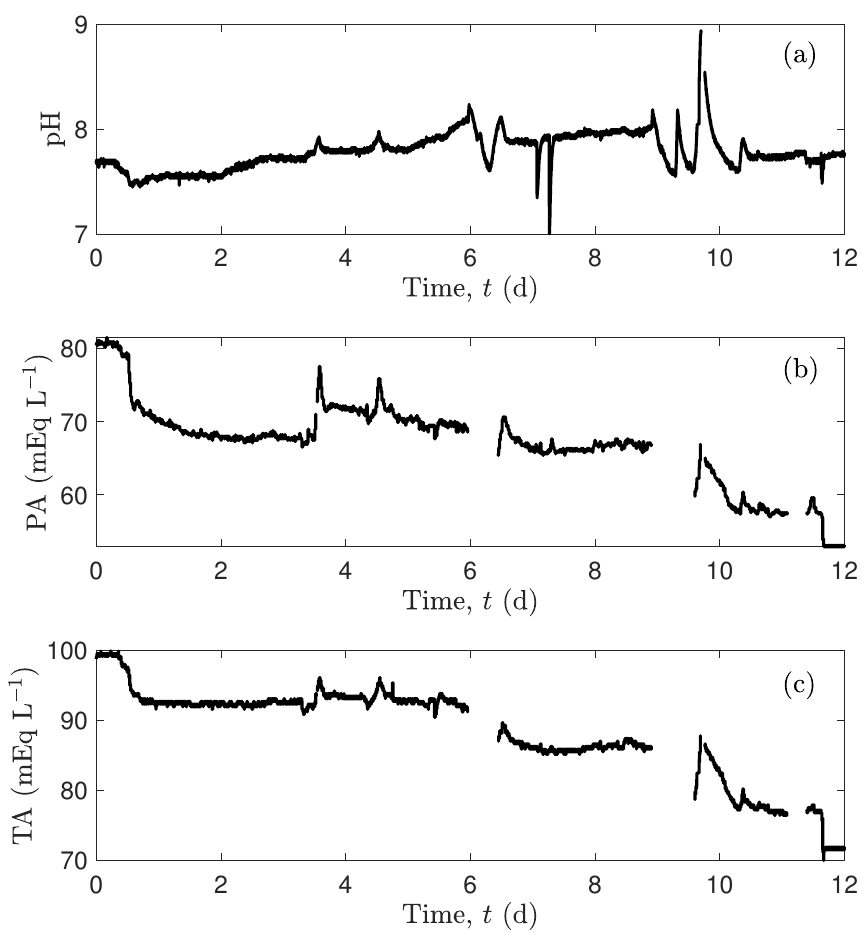
Figure 5. Experimental data: ( a ) pH, ( b ) partial alkalinity, and ( c ) total